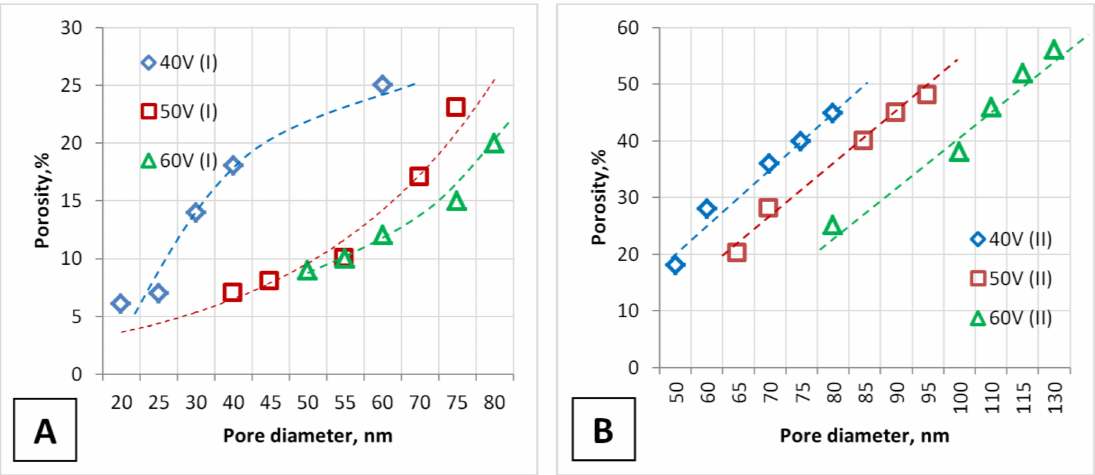
Figure 5. Dependence of the PAA porosity during one-stage ( A ) and two-stage ( B ) anodizing on the pore diameter and